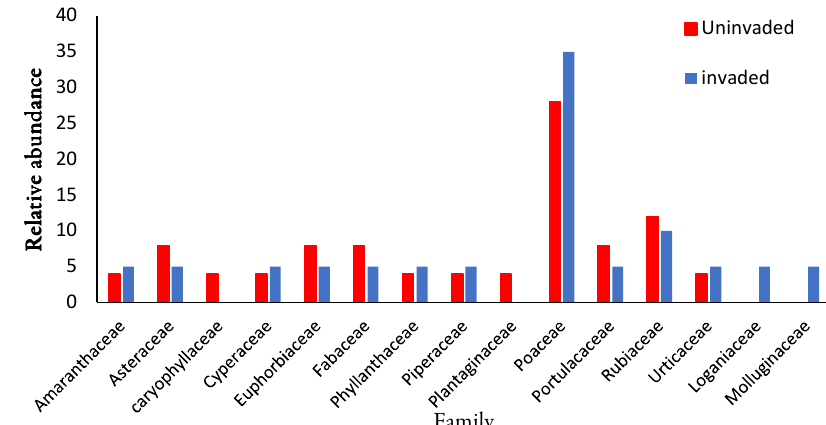
Figure 3. Families of plant species recruited from the seed bank at 15-30 cm depth At both the invaded and uninvaded plots, Mariscus alternifolius and Oldenlandia corymbosa were the most abundant species in the seed bank. The number of seedlings recruited from the soil seed bank from the invaded and uninvaded plots include O. corymbosa (73 and 513 seedlings), M. alternifolius (128 and 82), Eleusine indica (24 and 11), Panicum maximum (38 and 2), Mitracarpus villosus (33 and 31), Celosia leptostachya (80 and 3), and T. rotundifolia (13 and 12) respectively.